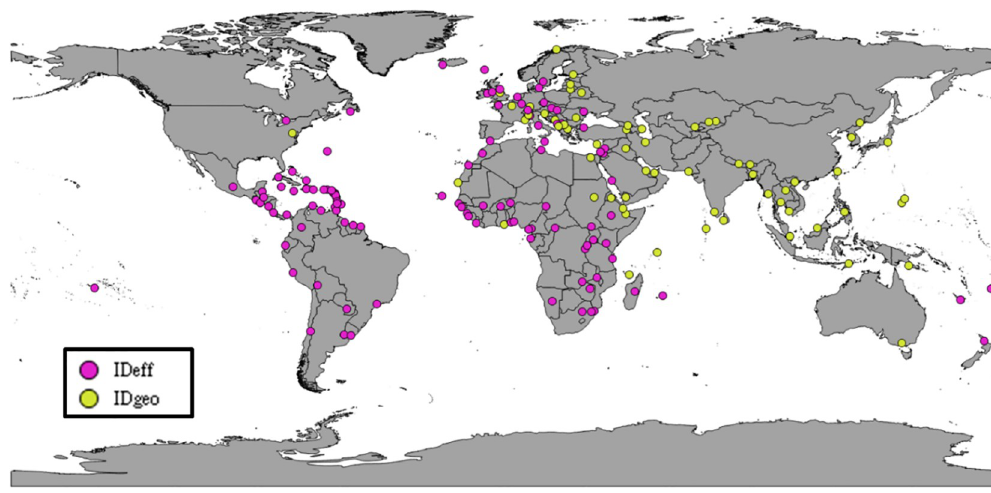
Fig 8. The map of maximum